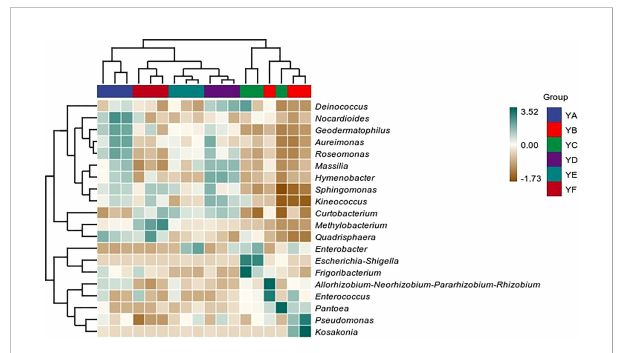
FIGURE 4 Heatmap of phyllosphere bacterial communities of different species of Populus spp. at the genus level. YA: Populus x euramaricana 'Bofeng 3 hao'; YB: P. deltoides 'Shanghaiguan' × P. deltides 'Harvard'; YC: P. nigra 'N46'; YD: P. nigra 'N102'; YE: P. x euramericana 'Guariento'; YF: P. alba × P. glandulosa